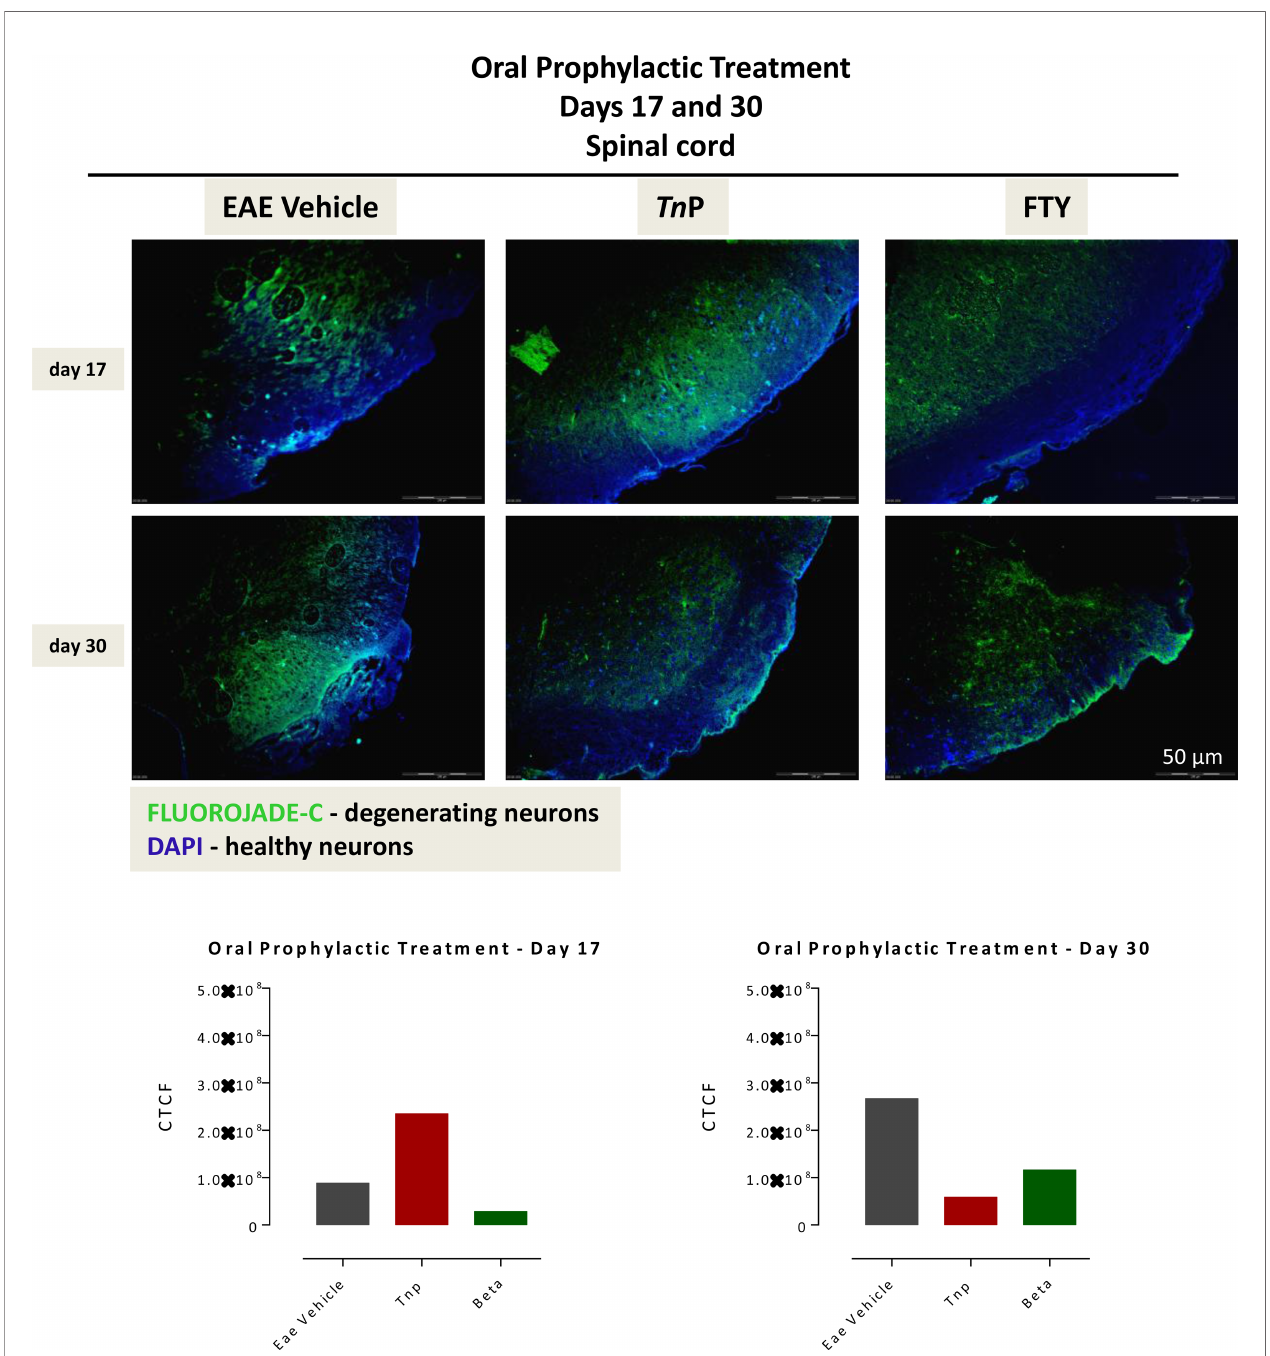
FIGURE 6 | Tn P orally administered promotes the long-lasting survival of neurons in spinal cord. The 10 micron-thick slices of spinal cord of vehicle-treated EAE or Tn P- and fi ngolimod-treated EAE mice removed at day 17 or 30 were prepared for immuno fl uorescent double-staining with Fluoro-Jade C (green) and DAPI (blue) for evaluation the degree of neurodegeneration in damage areas. Representative sections are shown. The fl uorescence staining was measured in ImageJ Software v.1.8.0_172. The corrected total cell fl uorescence (CTCF) was obtained utilizing the formula CTCF = Integrated Density – (Area of selected cell X Mean fl uorescence of background